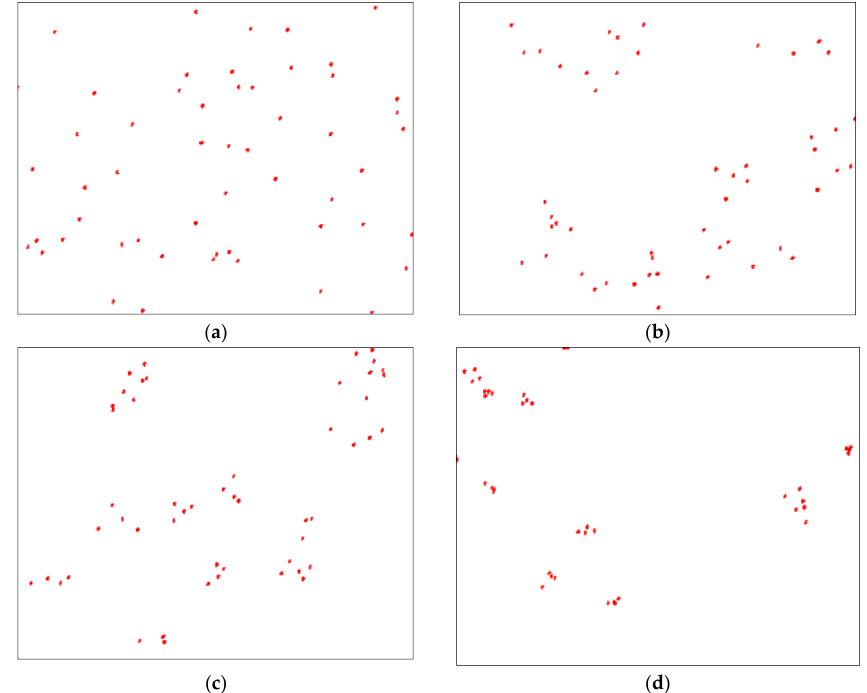
Figure 9. Examples of the spatial point distributions generated and tested in Figure 4, with ( a ) CSR, ( b ) σ = 8, ( c ) σ = 5, and ( d ) σ = 2.